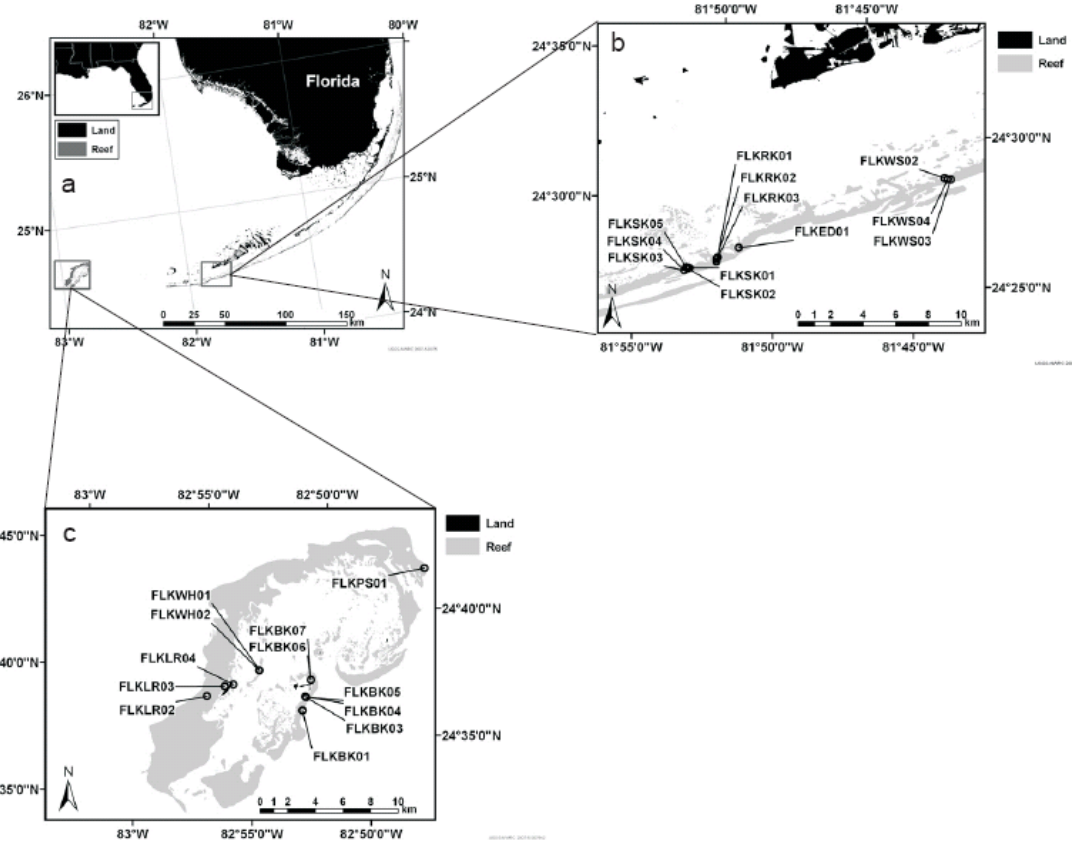
Figure 1. Regional survey areas in the ( a ) South Florida Reef Tract, United States, and specific survey stations in ( b ) Key West and ( c ) Dry